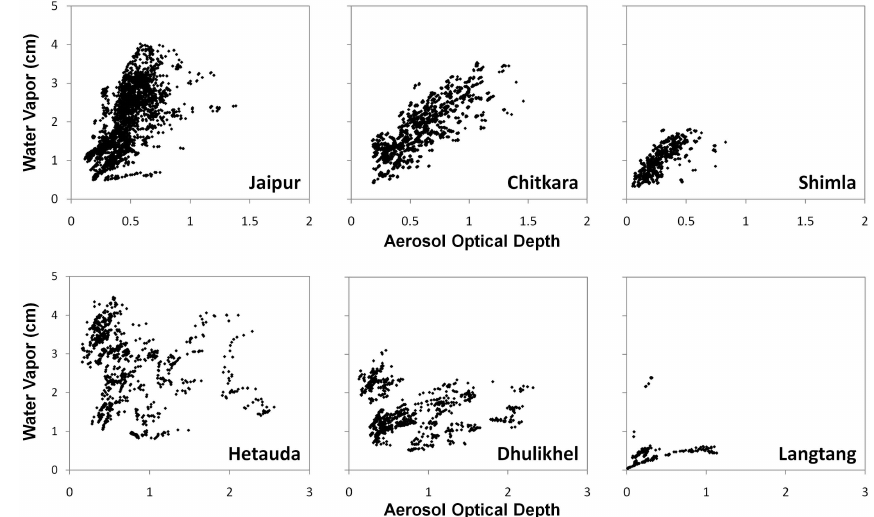
Fig. 6. Scatter plots between AOD and water vapor over Jaipur, Chitkara, Shimla in India (top), and Hetauda, Dhulikhel, Langtang (bottom) for the entire measurement period during the 2009 pre-monsoon season. Data points shown are instantaneous retrievals of AOD and water